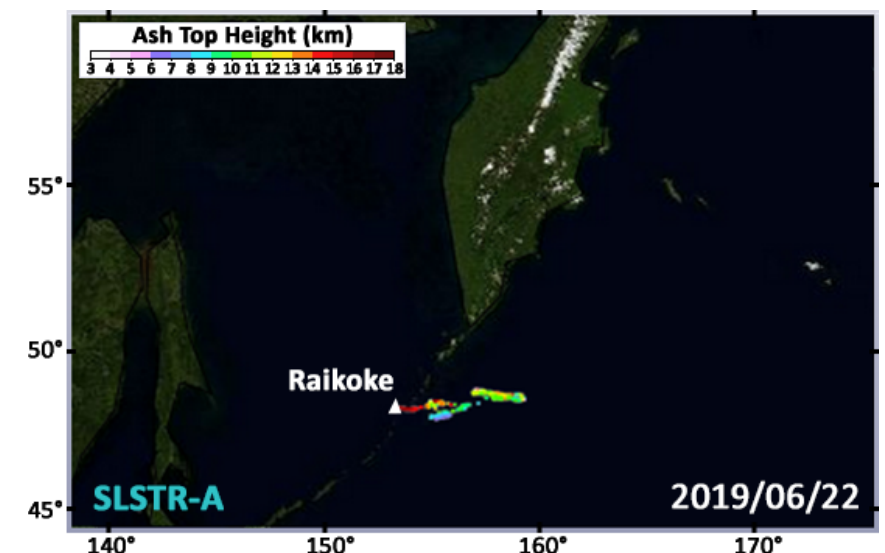
Figure 5. Characterisation of Raikoke plume by ash top height (in km) from SLSTR-A on 22 June 2019 (acknowledgement to NASA’s Global Imagery Browse Services – GIBS – for providing imagery used as a background). Please note that the date format in this figure is